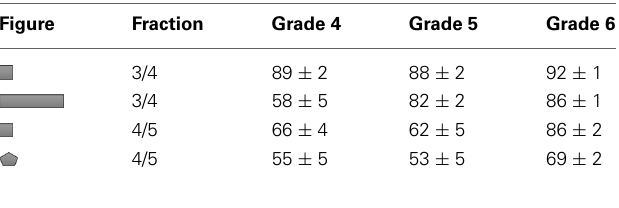
Table 4 | Mean scores and standard deviation for each item in which pupils had to shade 3/4 or 4/5 of a given figure.